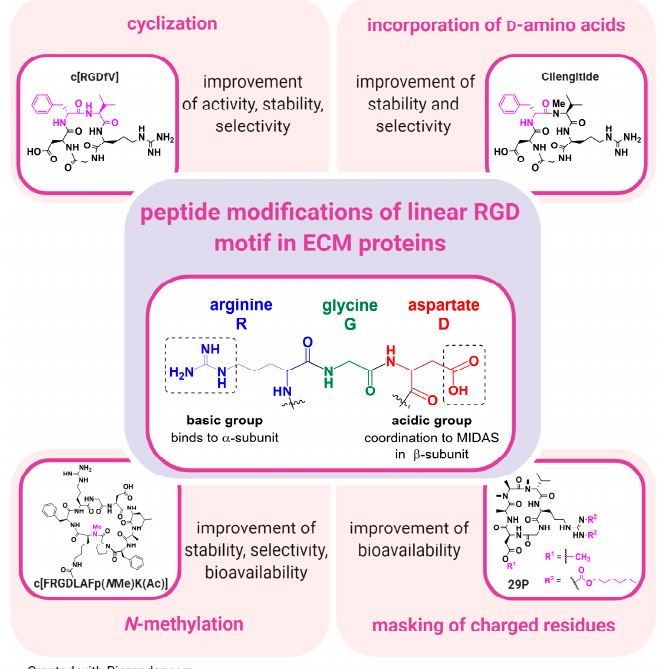
Figure 6. Exemplary peptidic modifications for improving the activity, stability, selectivity, and/or bioavailability of synthetic peptidic integrin ligands. The amino acids RGD coordinate to both integrin subunit: the basic amino acid Arg coordinates to the α -subunit, while Asp coordinates to the Metal Ion-Dependent Adhesion Site (MIDAS) region in the β -subunit. Starting from this linear RGD sequence contained within ECM proteins, various modifications were introduced for improving the integrin targeting properties. The cyclization of peptides and the incorporation of d-amino acids (e.g., cyclo[RGDfV] or Cilengitide) for example improved especially the stability and selectivity of the respective integrin ligands. N -methylation (e.g., cyclo[FRGDLAFp( N Me)K(Ac)] and the masking of charged residues (carboxylic and guanidinium group in 29P) contributed to a better bioavailability of the named compounds. Furthermore, N -methylation led to a higher stability and selectivity of the respective compounds.